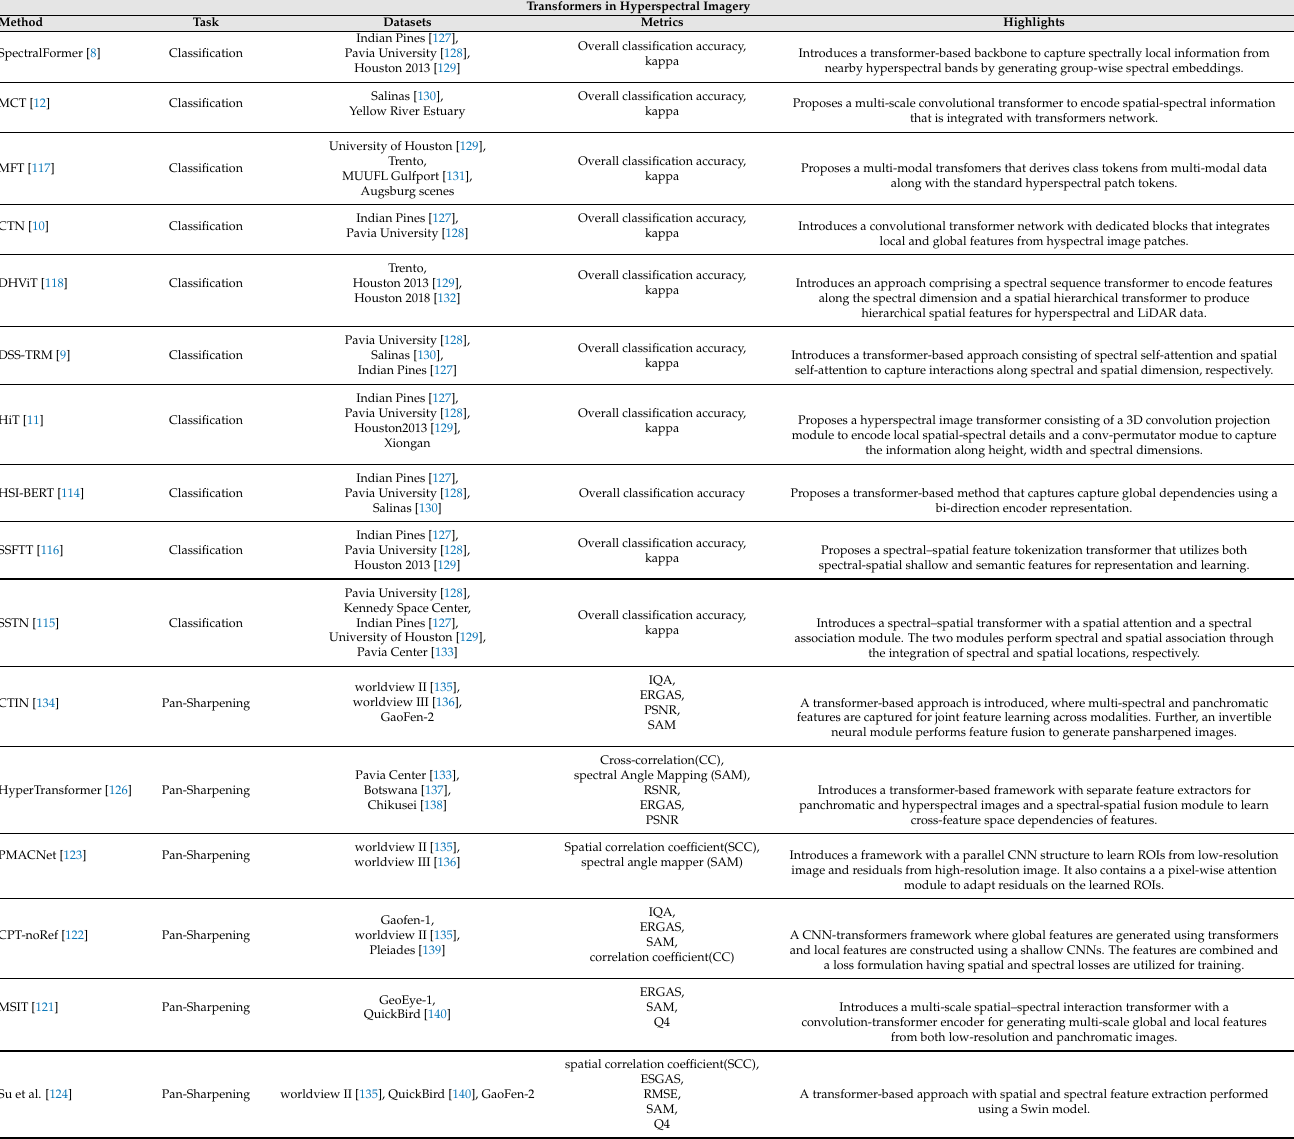
Table 8. Overview of transformer-based approaches in hyperspectral and multispectral imaging. Here, we highlight methods for different hyperspectral remote sensing